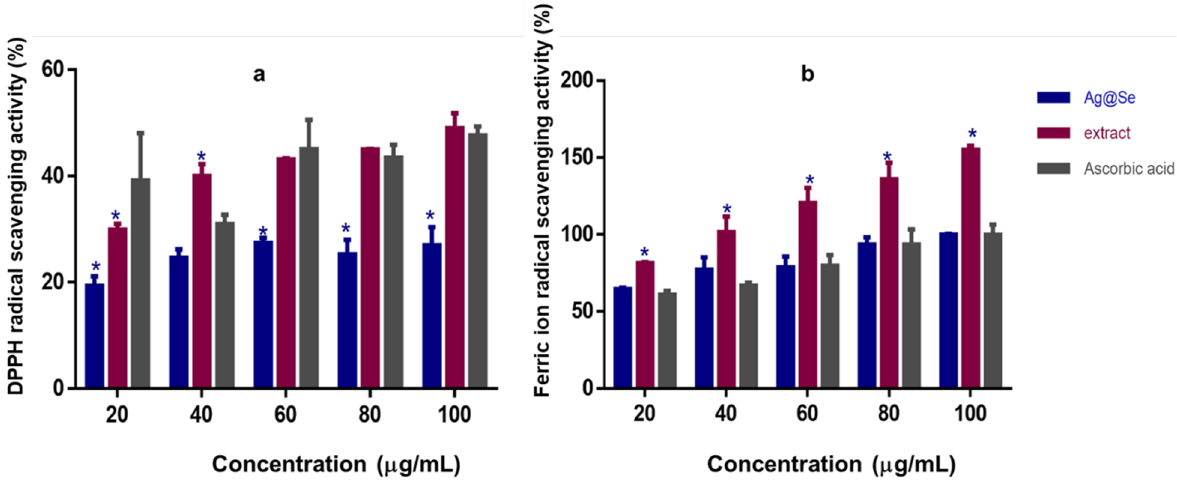
Figure 4. ( a ) 2, 2-diphenyl-1- picrylhydrazyl (DPPH) radical scavenging activity, and ( b ) ferric ion scavenging activity of Ocimum tenuiflorum extract and Ag@Se NPs compared to ascorbic acid. Data are presented as mean ± SD ( n = 3). * p < 0.05 for statistical significance compared to standard antioxidant (ascorbic acid). Table 4. The IC 50 value for antioxidant and cytotoxicity studies on Ag@Se NPs. Nanoparticle/Drug